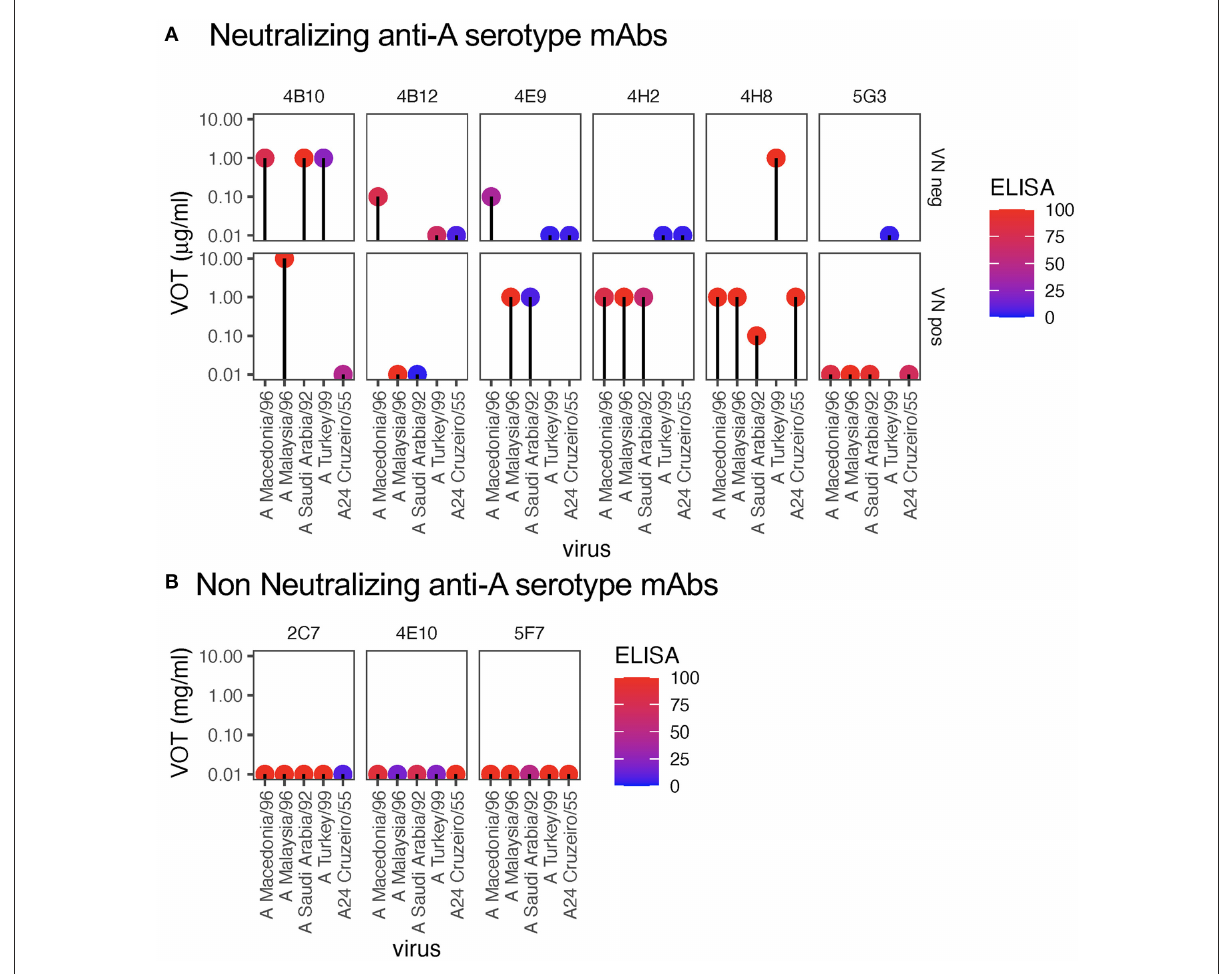
FIGURE2 Virus opsonizing titers of mAbs against serotype A FMDV. For each virus (x-axis), the dots show the virus opsonization titers (VOT, y-axis), with the panels representing different anti-A serotype mAbs (see Table 1) as in Figure 1. The colors of the dots reflect the ELISA reactivity (legend). The panels in (A) show the data for mAbs that neutralize homologous virus. The upper panels show the VOT data for mAb-virus pairs without neutralization (“VN neg”), while the lower panels represent mAb-virus pairs with neutralization (“VN pos”). In (B) , the data for mAbs with no neutralizing activity against homologous virus are